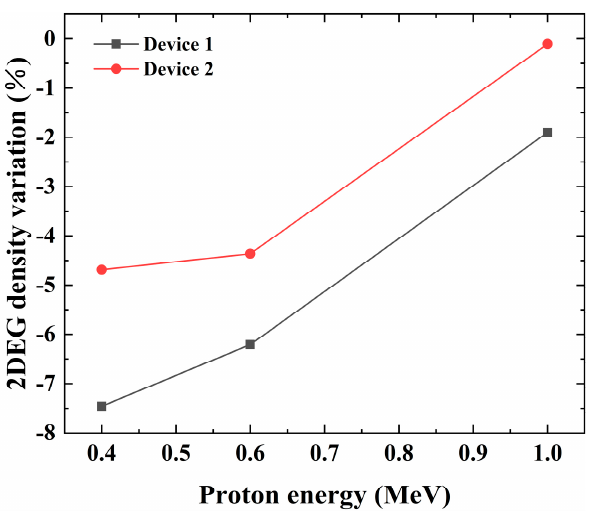
Figure 9. Level of the 2DEG electron density variation after proton irradiation at gate–source voltage V GS = 0 V as a function of proton energy. V GS = 0 V as a function of proton